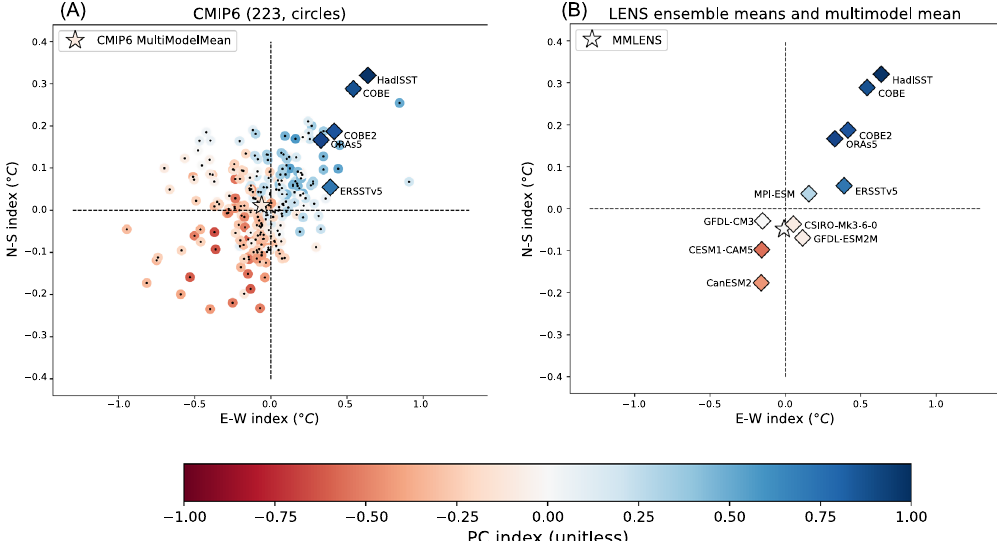
Fig. 4 Tropical Paci fi c SST Trends from 1958 to 2018. Trends in the east-west SST gradient as measured by (a western box (140 o E-170 o E, 3 o S-3 o N) minus an eastern box (170 o W-90 o W, 3 o S-3 o N); horizontal axis), north-south near-equatorial SST gradient (the average of off- equatorial box (9 o S-3 o S, 3 o N-9 o N) minus equatorial box (3 o S-3 o N) all for longitudes 170 o W-120 o W; vertical axis), and the pattern correlation between the HadISST and simulated SST in the Paci fi c Ocean 10°S-10°N domain (color dots). A 511 individual realizations (colored dots) from 45 CMIP6 models, and the multimodel ensemble mean (white star); ( B ) Six multimodel LENS ensemble means (colored diamonds) and the six- model LENS ensemble mean (white star) 2 . Also shown in each panel are observation-based estimates from HadISST, COBE, COBE2, ERSSTv5, and ORAs5 (diamonds). Units for SST gradients are o C per 61 years. This plot is adapted from ref. 2 (© American Meteorological Society. Used with permission.) which provides additional information on the data used and the